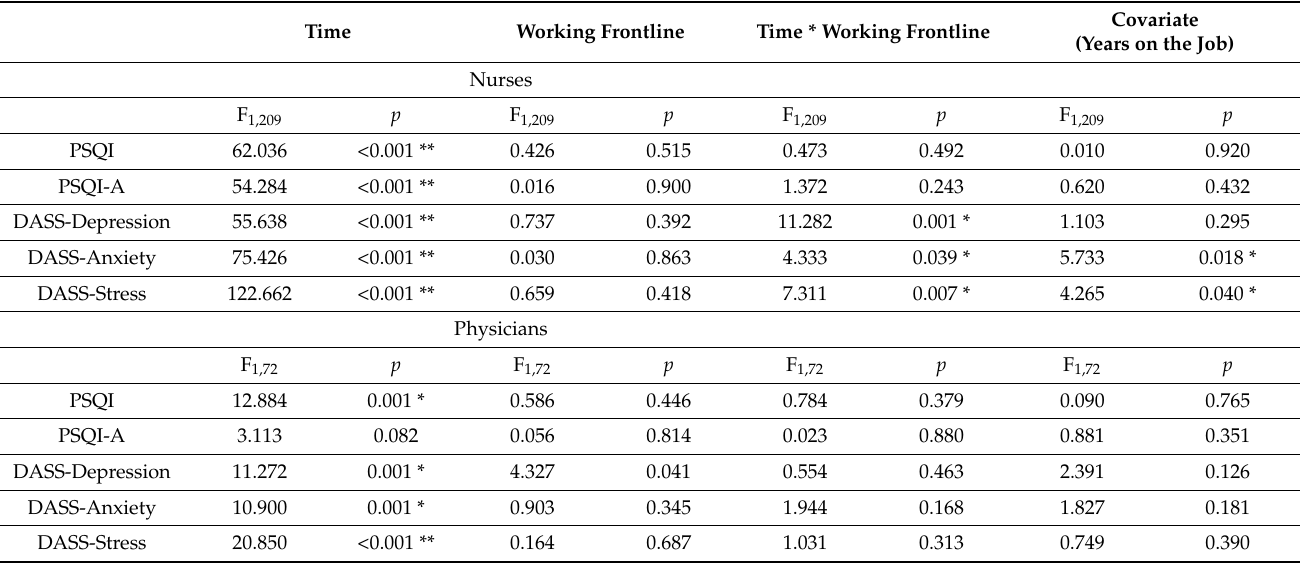
Table 3. Univariate test of the two-way mixed MANCOVAs with “Years on the job” as covariate and “Time” and “Working frontline” as within and between factors, respectively, on nurses (n = 212) and physicians (n = 75).